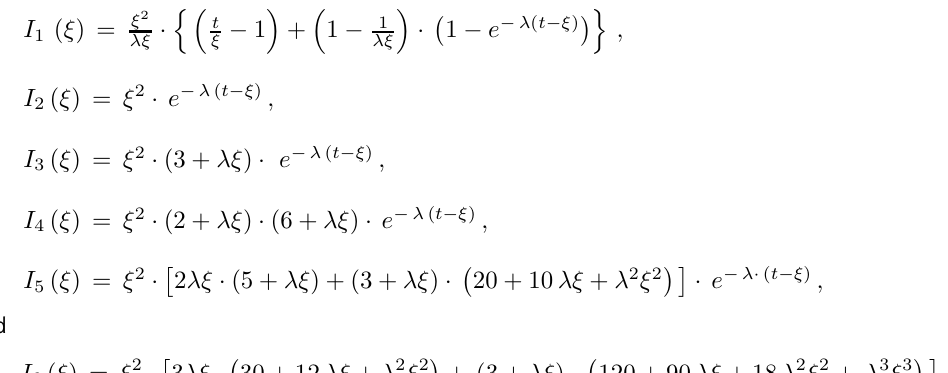
Fig. 3. Typical time history of the normalized shear stress at a field point within the linear-elastic half-space domain under a train of three sequential load